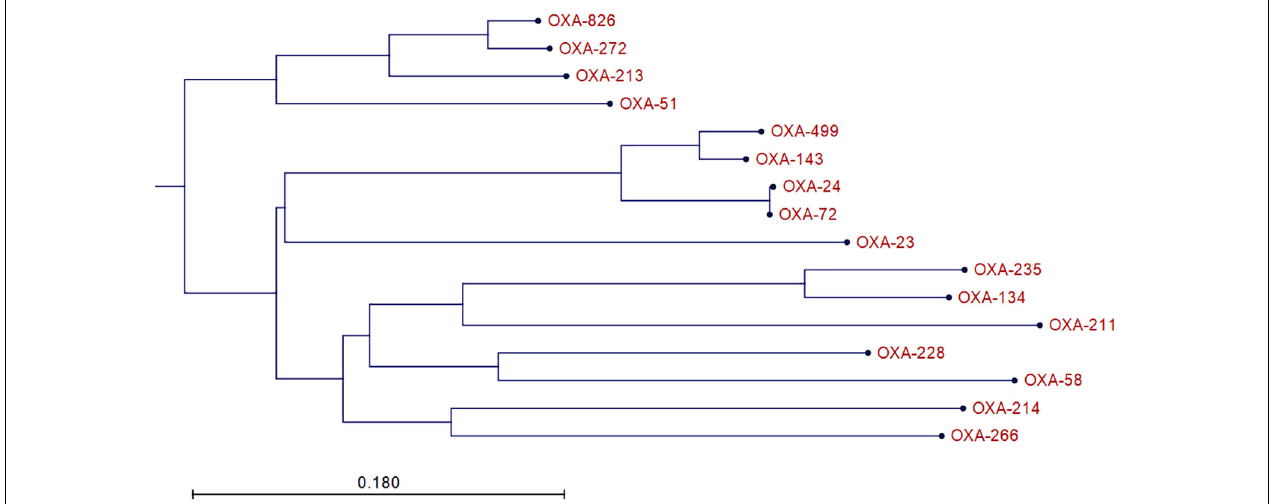
FIGURE 1 | Phylogenetic tree of relative OXA variants. The neighbor-joining tree was generated using CLC Main Workbench 8.5.1 (QIAGEN